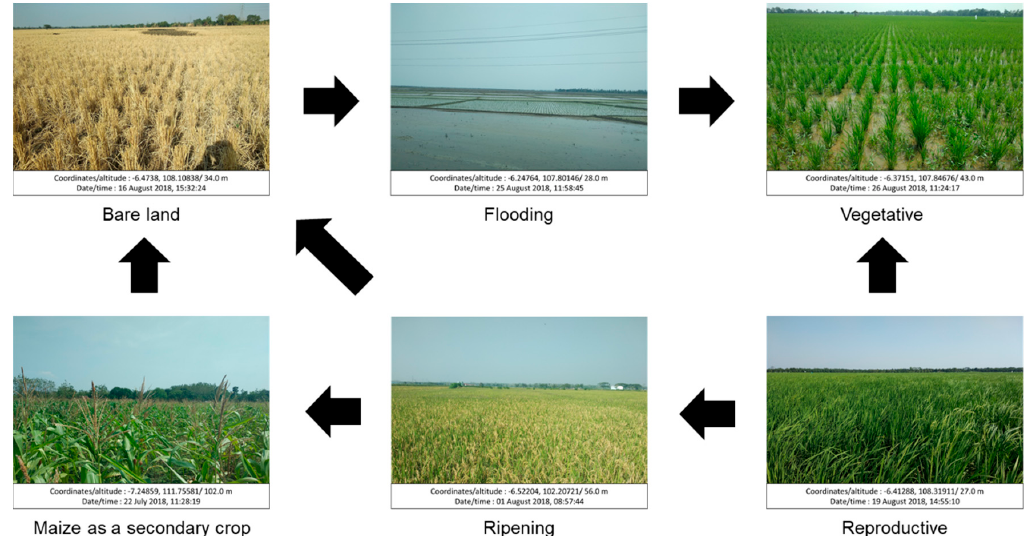
Figure 1. The example of rice growth stages and other rice field conditions in the paddy field area. The geolocation and date stamped on the photos.